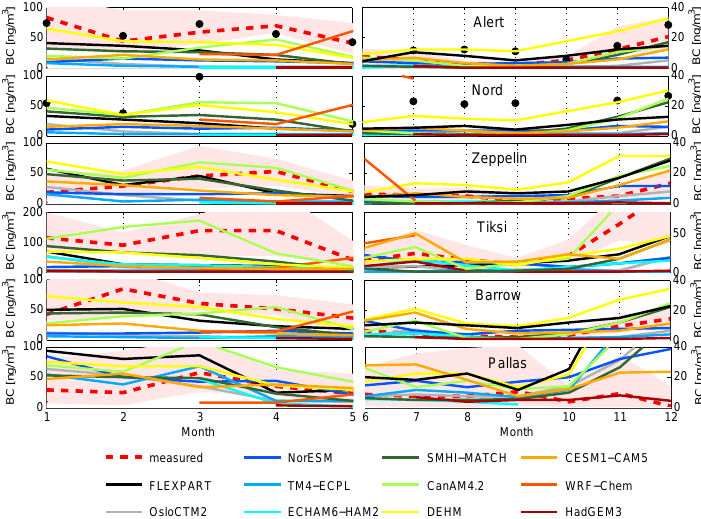
Figure 5. Surface concentrations of monthly (month is displayed on the abscissa) median observed eBC or EC and modeled BC. Each row represents one station: (from top) Alert, Nord, Zeppelin, Tiksi, Barrow and Pallas, for late winter/spring (left column) and summer/fall (right column). The red dashed lines connect the observed median eBC values, and the light red shaded areas span from the 25th to 75th percentiles of the observations. The black dots are the EC concentrations, which are available for Alert and Station Nord. Modeled median values are shown with different lines according to the legend. Notice the difference in concentration scales used for the left and right panels and also for the Tiksi